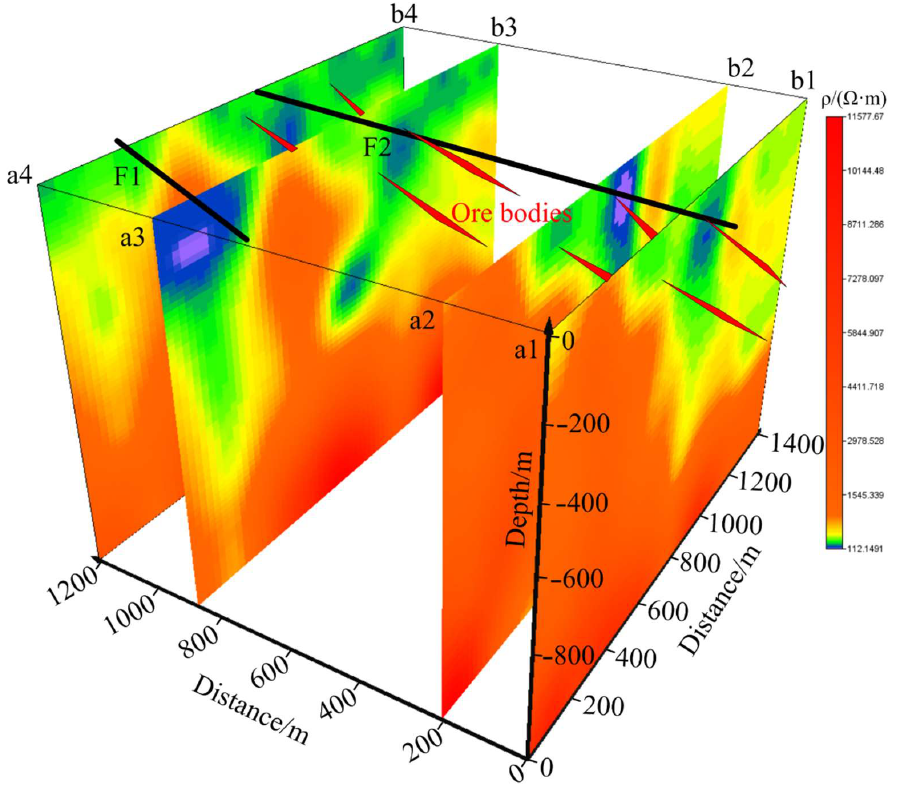
Figure 8. Depth–resistivity cross section of four survey lines.